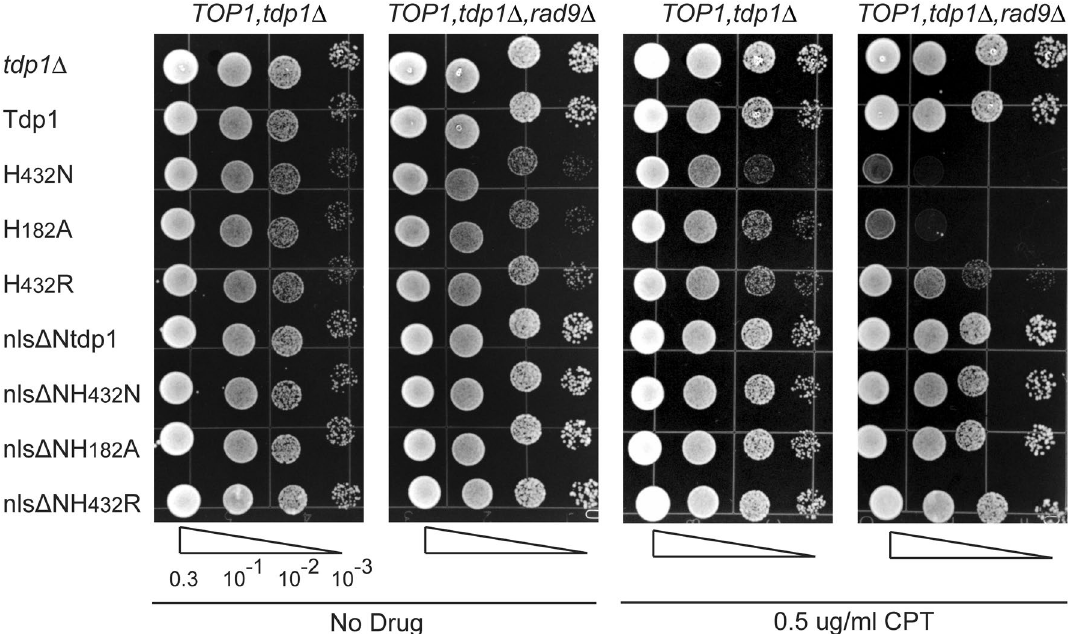
Figure 4. N-terminal truncated Tdp1 catalytic mutants do not reduce viability in the DNA damage impaired hypersensitive rad9 Δ-strain. TOP1 , tdp1 Δ and TOP1 , tdp1 Δ, rad9 Δ cells were transformed with control vector ( tdp1 Δ) or the indicated YCpGAL1- TDP1 L plasmid. Exponentially growing cultures were diluted to an OD 600 of 0.3 and three times ten-fold serially diluted (10 –1 , 10 –2 , 10 –3 ) and spotted onto selective galactose plates, with or without 0.5 μg/ml camptothecin (CPT). Plates were incubated at 30 °C for 4 days. Shown are representative agar plates, cropped for clarity after adjustment of intensity of the whole plate using photoshop. All shown with and without CPT images are from one agar plate,